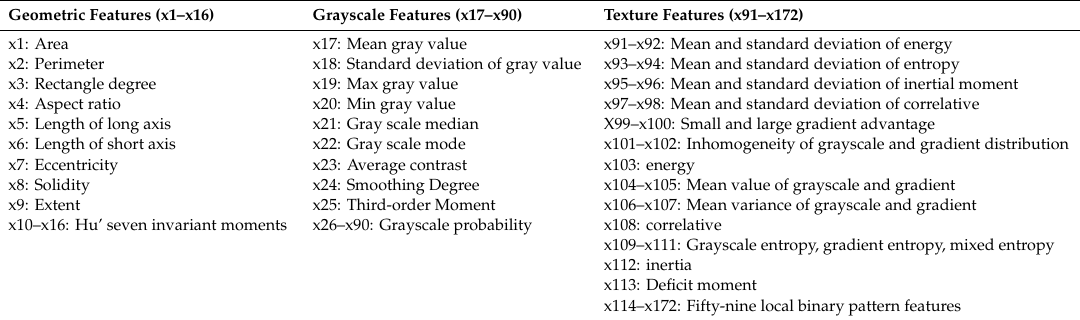
Table 2. Feature space utilized in this